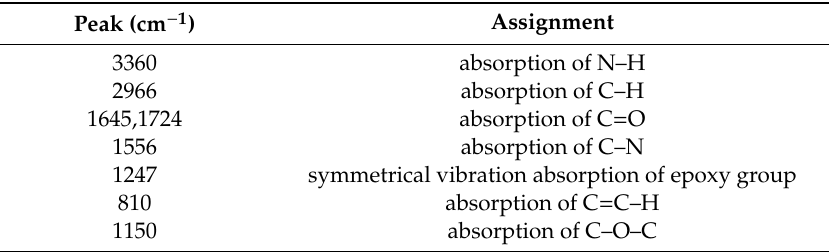
Figure 3. Infrared spectroscopy of microcapsules with the mass ratio of core to wall materials: 0.83:1. Table 3. Assignment of